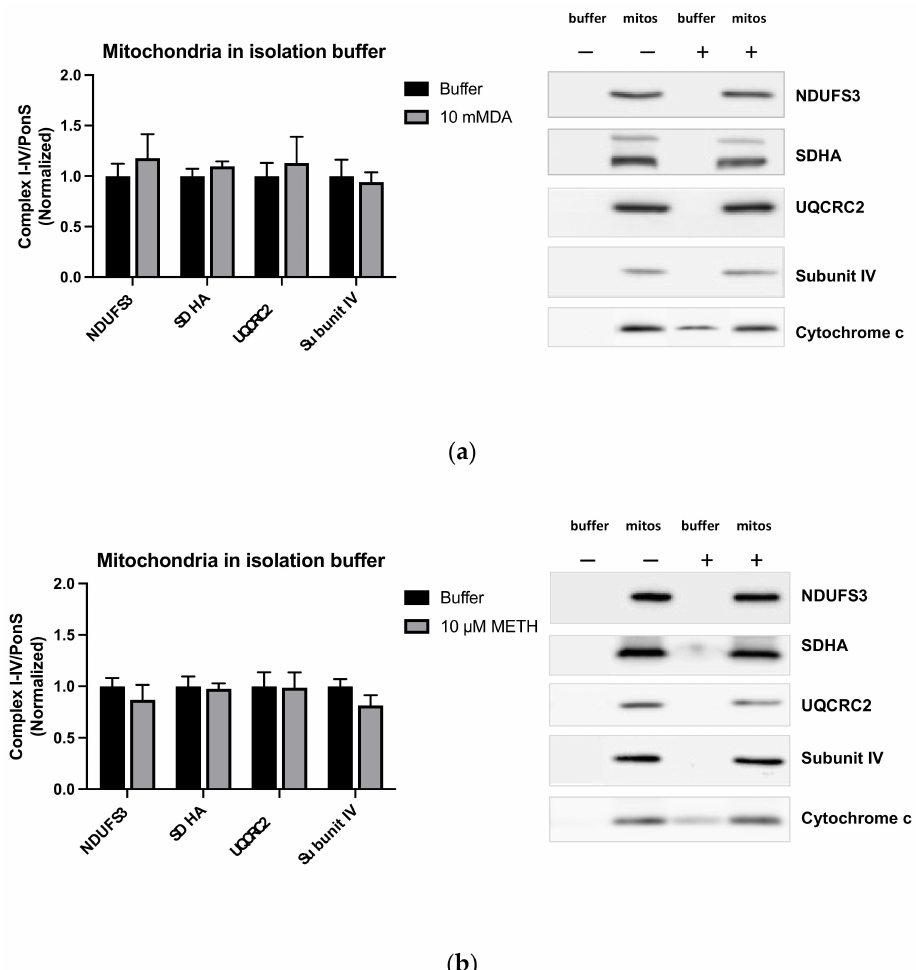
Figure 4. Effects of 10 mM DA ( a ) or 10 µ M METH ( b ) on cytochrome c, NDUFS3 (complex I), SDHA (complex II), UQCRC2 (complex III), and subunit IV (complex IV) in isolation-buffer-suspended mitochondria. An increase in cytochrome c immunoreactivity was observed in the cytoplasm (Lane 3) after incubation of mitochondria with DA or METH. No significant changes were observed in the levels of mitochondrial